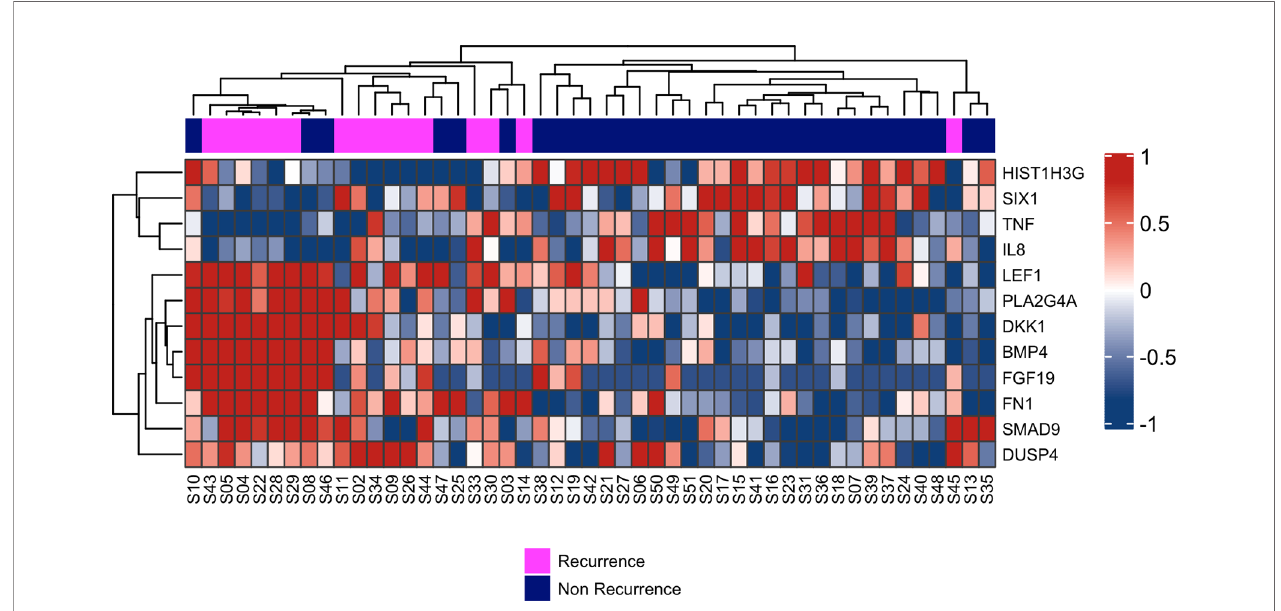
FIGURE 1 | Hierarchical clustering of the 12 RNAs differentially expressed between patients who presented recurrence (pink) compared to those who did not relapse (purple). On the right side: gene expression scaling from dark blue (downregulated) to dark red (upregulated).